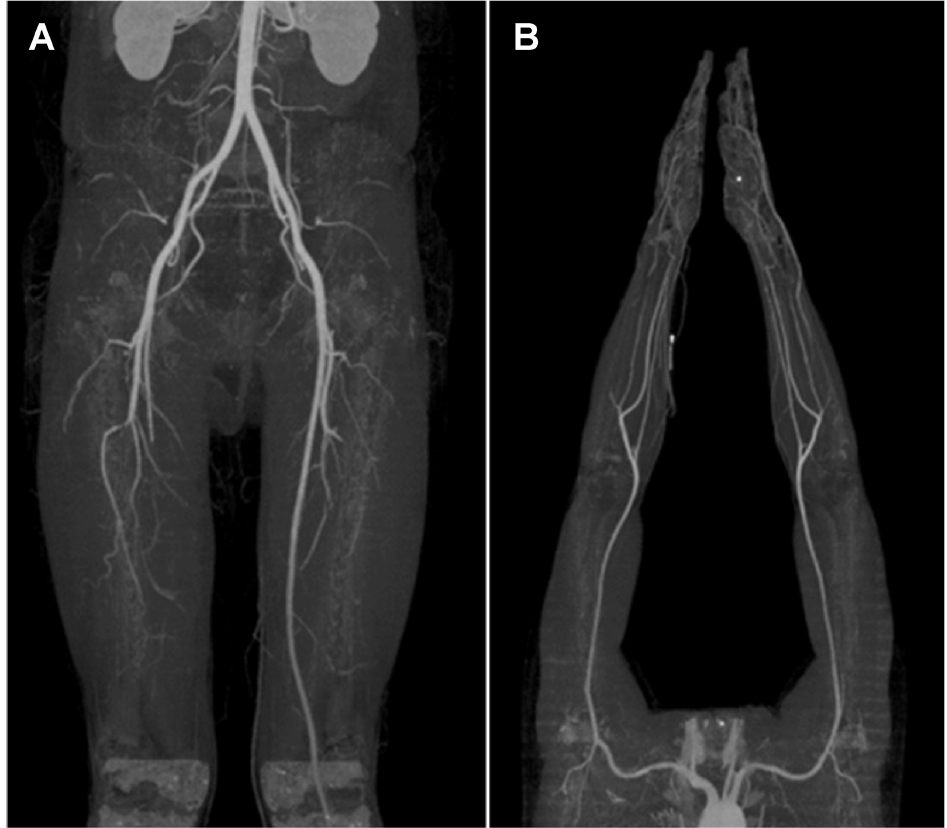
Figure 2. ( A ) Lower extremity computed tomography angiography showing abrupt occlusion of the right popliteal artery; ( B ) Upper extremity computed tomography angiography showing total occlusion at both distal ulnar arteries with corkscrew